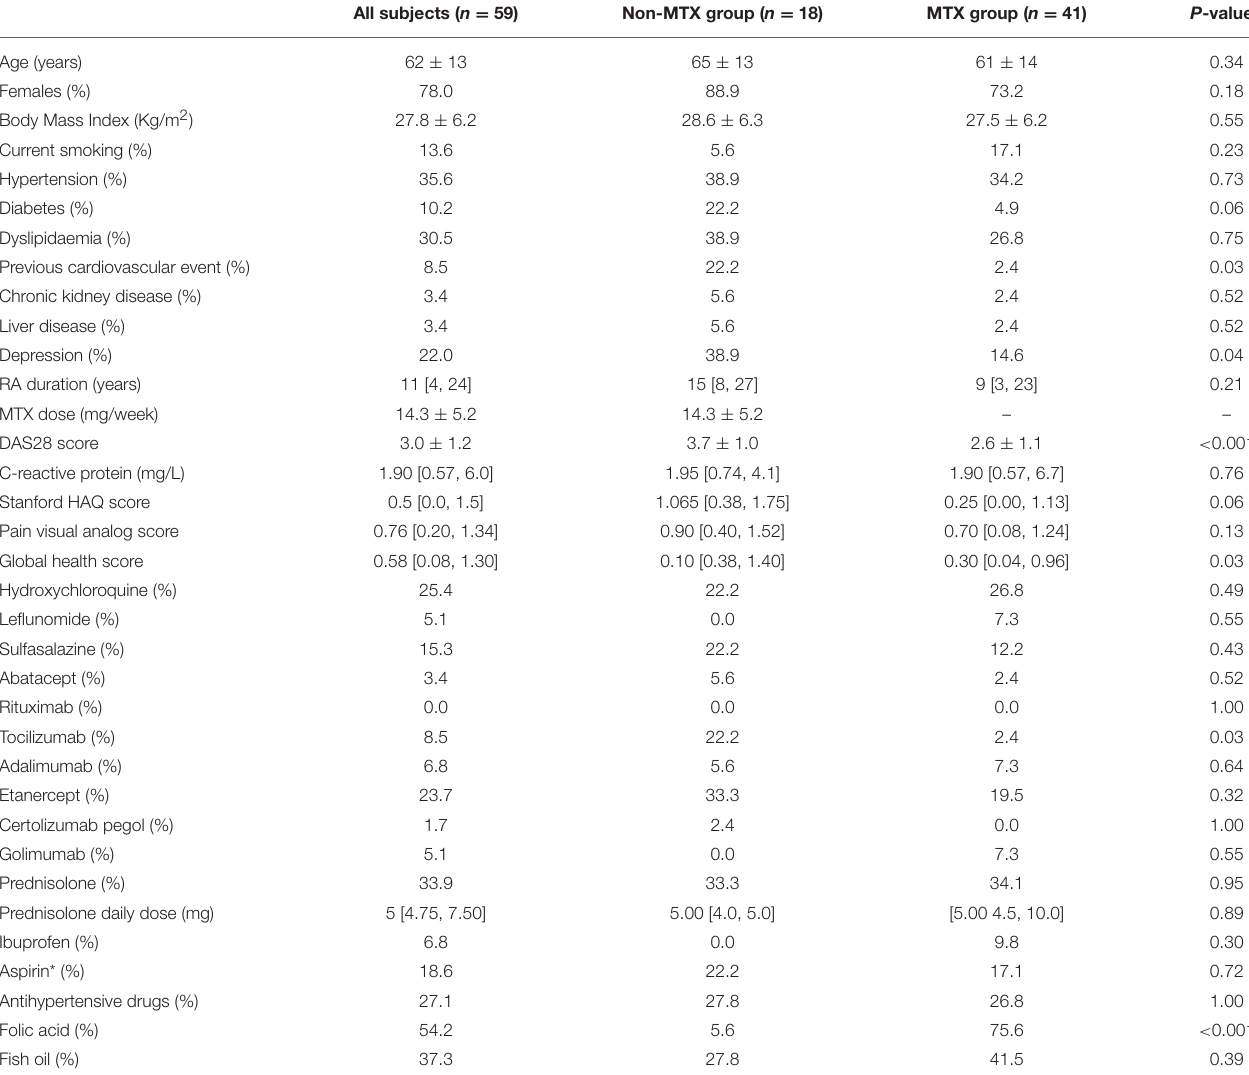
TABLE 1 | Baseline clinical and demographic characteristics of the MTX and the non-MTX groups. All subjects ( n = 59) Non-MTX group ( n = 18) MTX group ( n = 41)